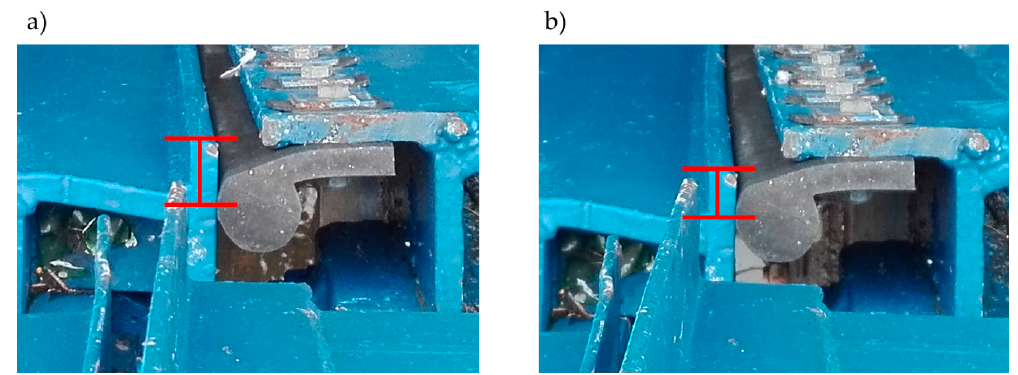
Figure 19. The shift between the gate’s leaves. ( a ) Position after sudden movement; ( b ) Position before sudden movement.